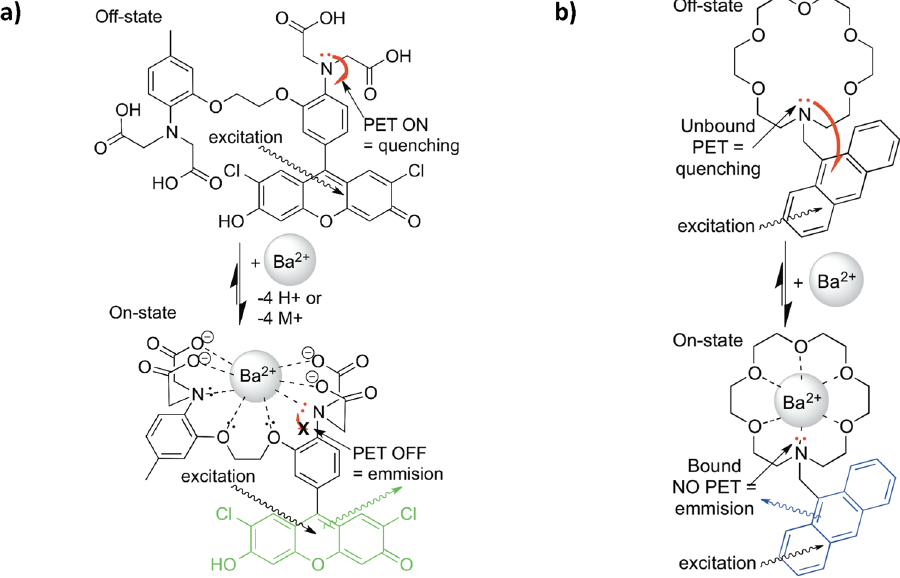
Figure 1. Cartoon showing binding and turn-on fluorescence in dyes ( a ) FLUO-3, used in 23,29 and ( b ) 18c6-an, developed for this